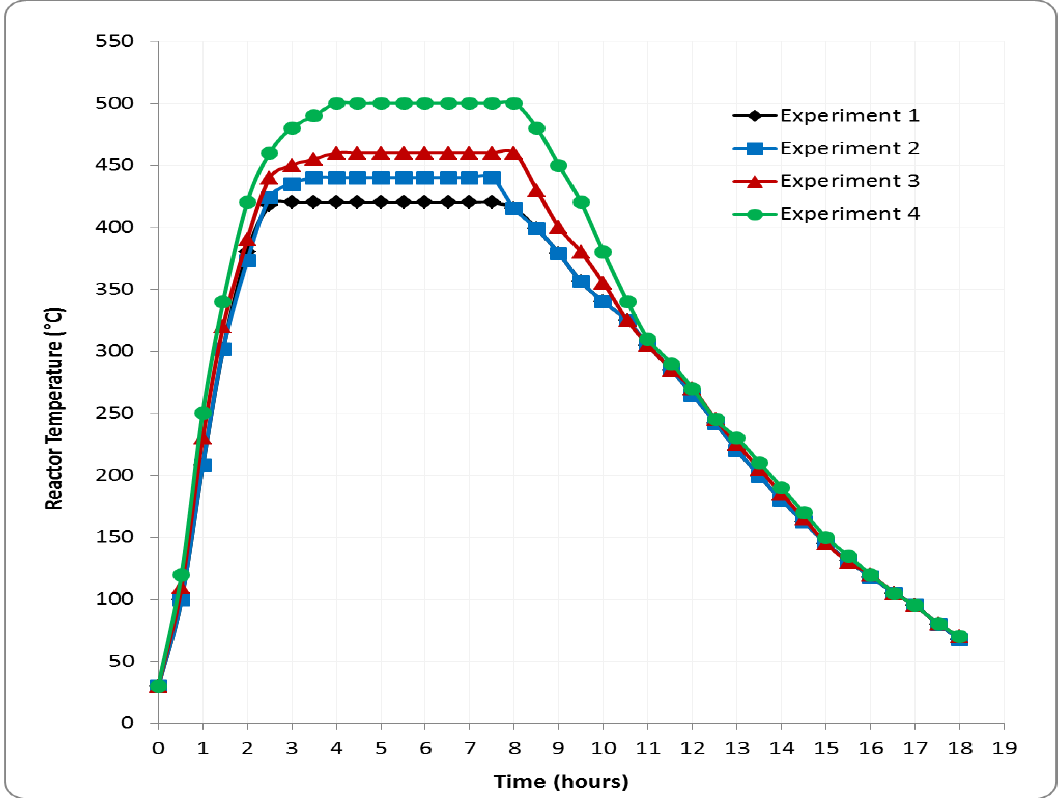
Figure 3. The reactor temperatures during heating and cooling for the four experiments.